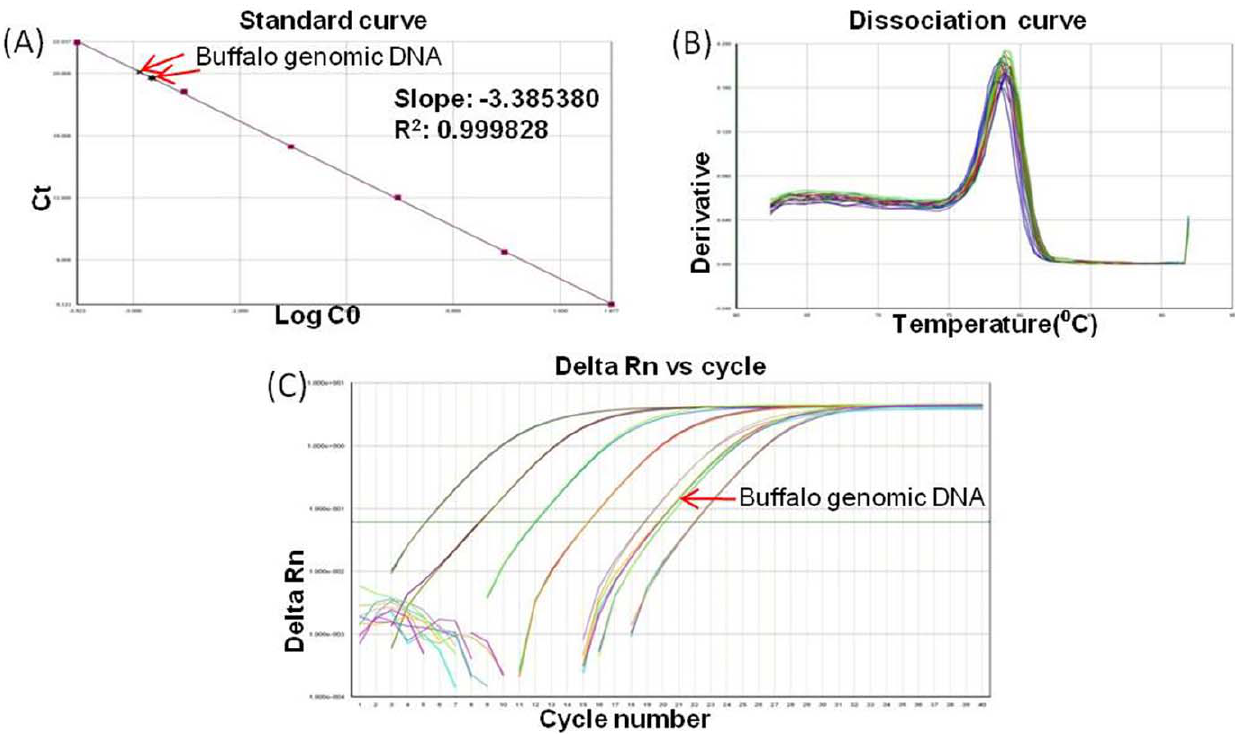
Figure 8. Copy number assessment of TSPY1 - like gene by q-PCR. q-PCR amplification plot from a 10-fold serial dilution of the plasmid for copy number calculation. ( A ) Standard curve, ( B ) Dissociation curve showing single peak, which indicates primer specificity with the target DNA. ( C ) Delta Rn vs Cycle showing amplification plots of the standard plasmid and water buffalo genomic DNA.